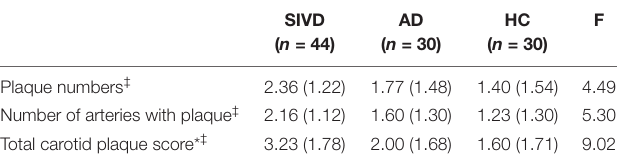
TABLE 5 | Carotid plaque by the